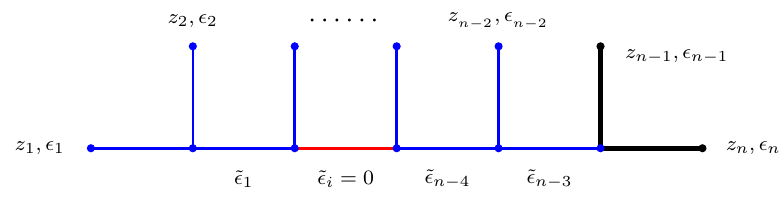
Figure 10 . i -th identity block: ~ (cid:15) i = 0, the identity channel is shown in Figure 7 . i -th identity block: ˜ ✏ i = 0, the zeroth channel is shown in red.